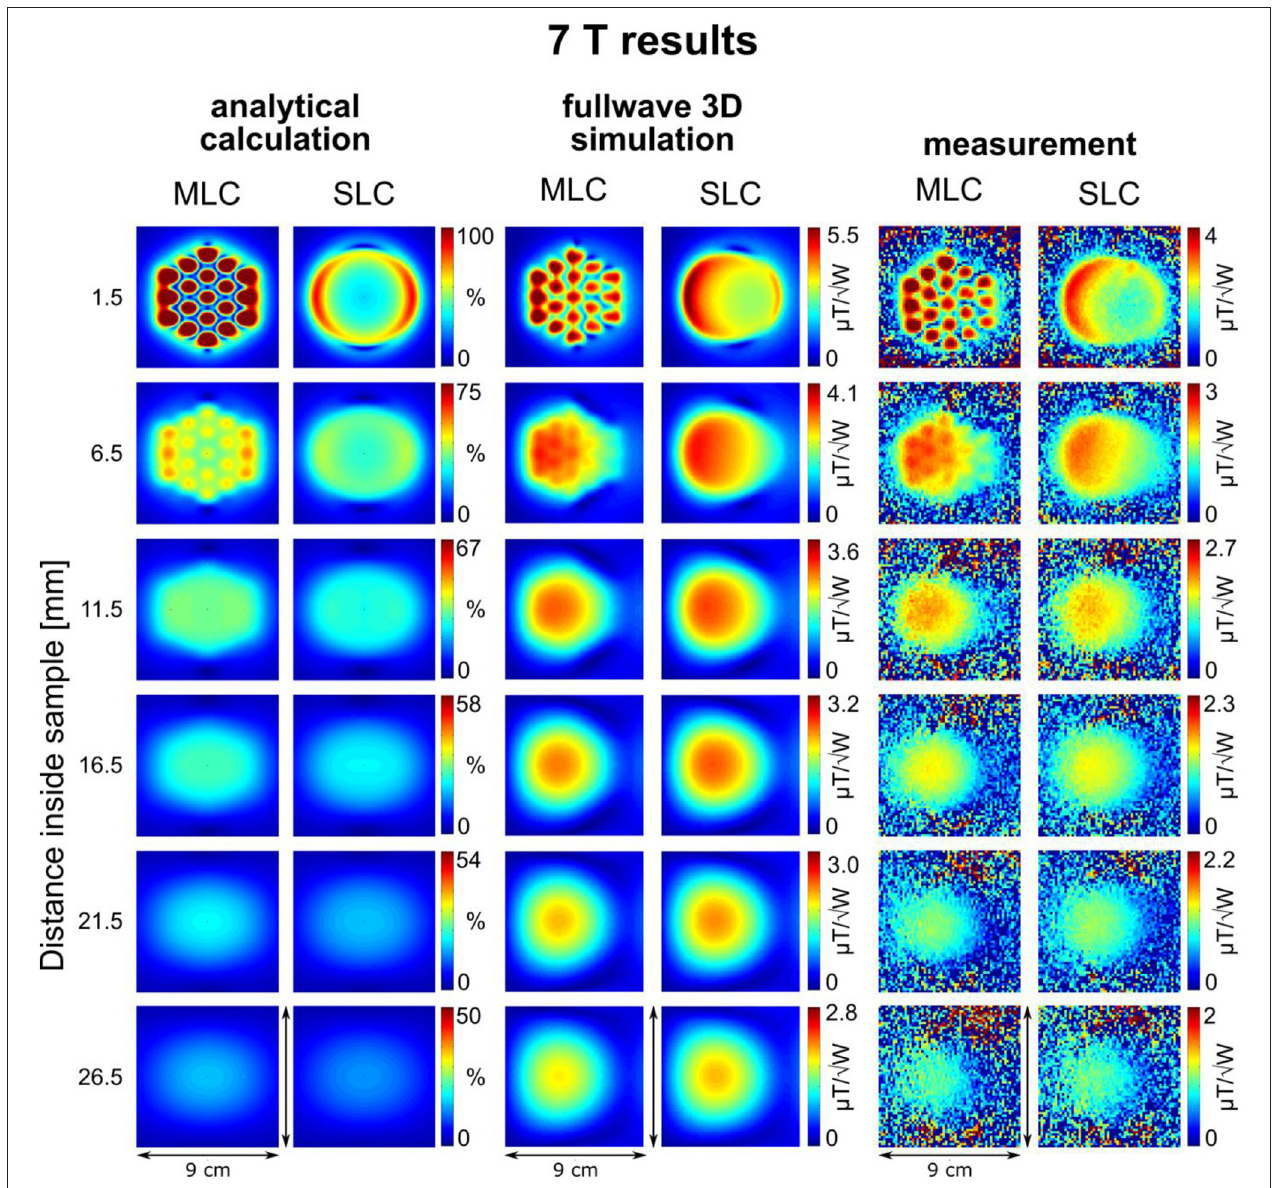
FIGURE 4 | Maps of the calculated sensitivity factor, as well as the simulated and measured transmit efficiency at different depths inside the sample for 7T coils. Calculated sensitivity factor values are normalized by the maximum sensitivity value obtained with the MLC at 1.5mm distance inside the sample. Note that the dimensions of the maps are different from 3T images due to the smaller coil